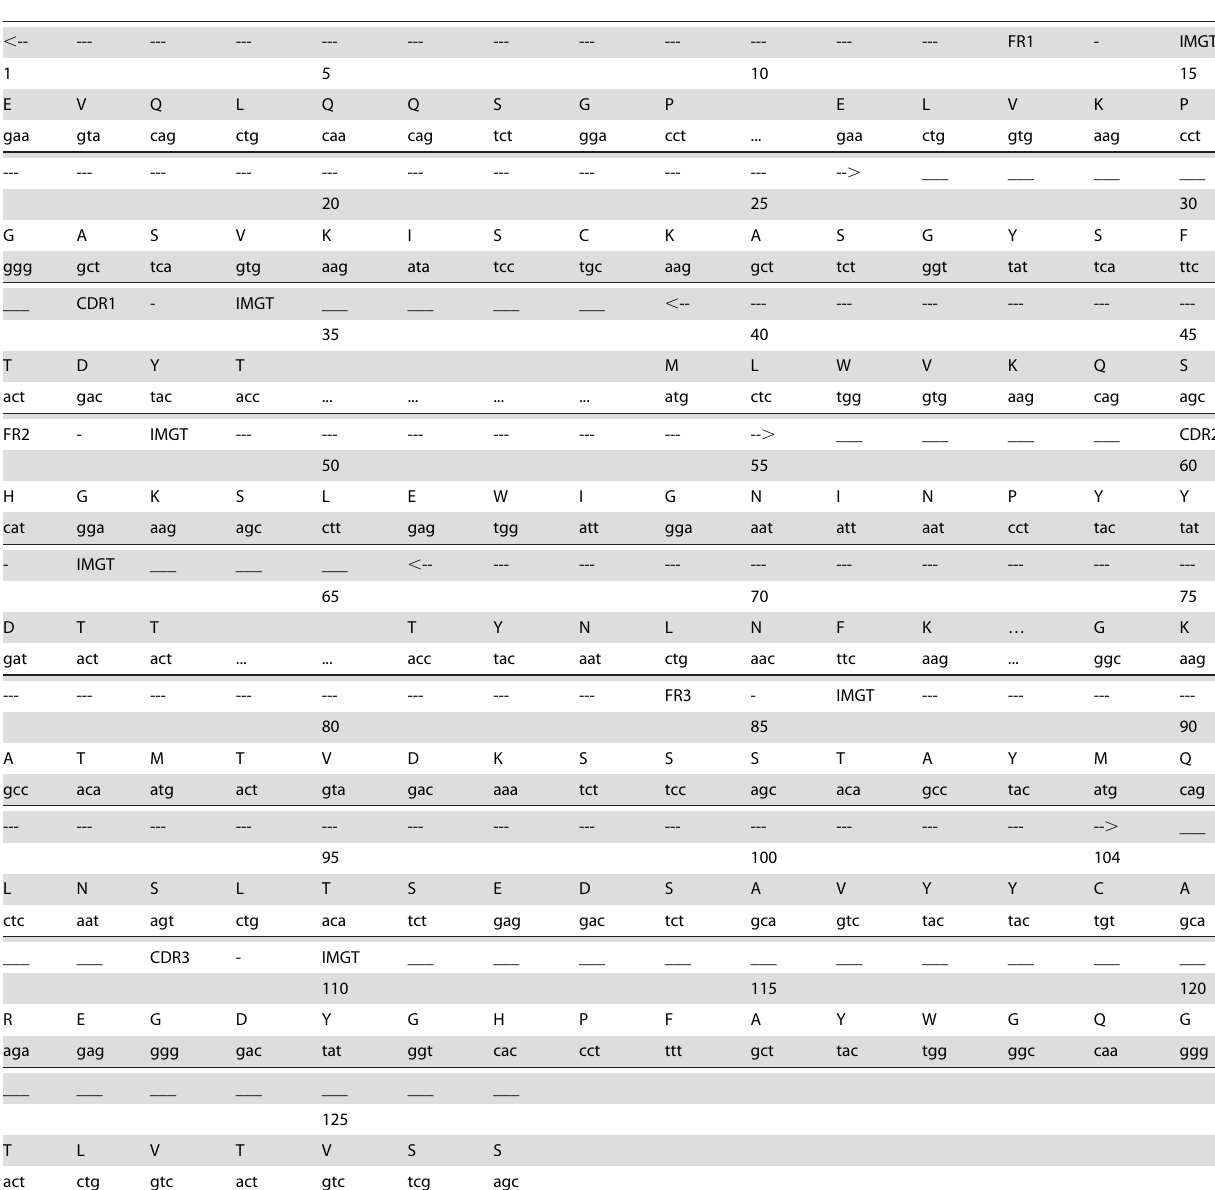
Table 5. Framework (FR) and Complementary Determining Region (CDR) delimitations of the heavy chain of MAb DB81: DB81